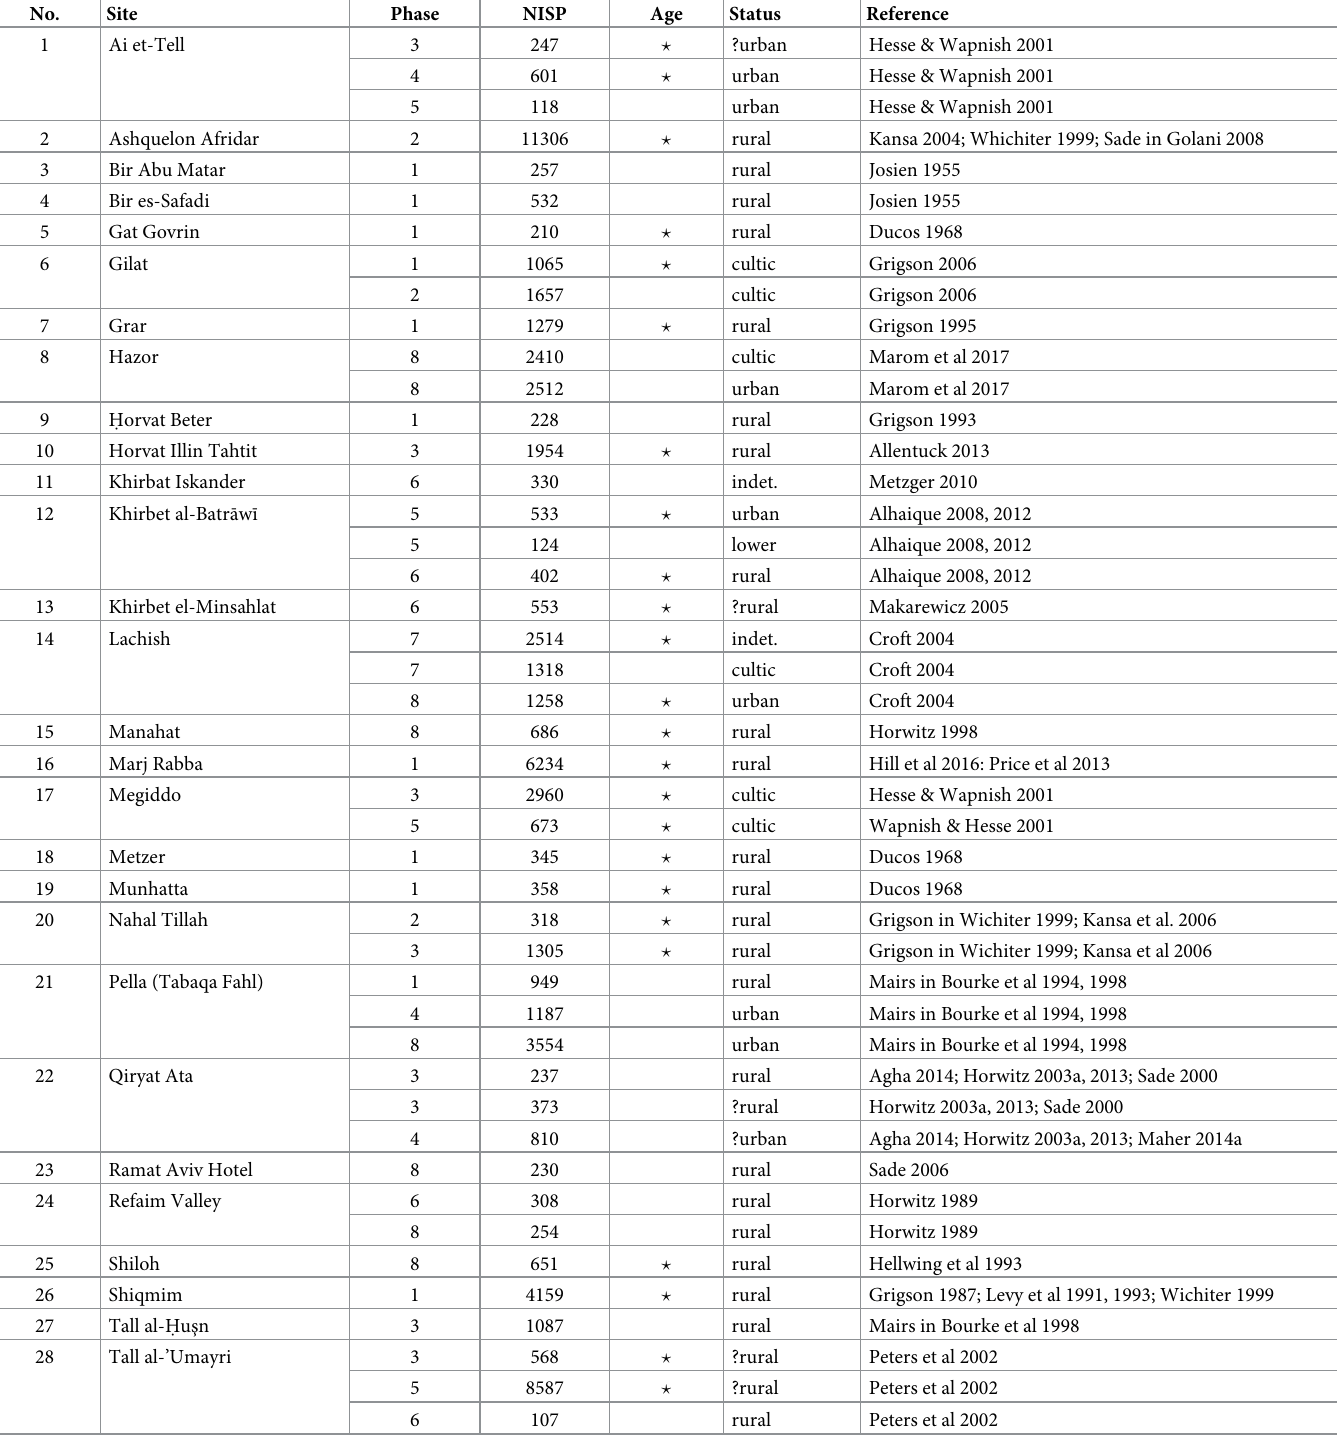
Table 2. Summary information for faunal samples compared in this study. The date ranges for chronological phase-groups and periods can be found in Table 1. Full bibliographic citations for the faunal samples used in this study can be found in SI3. Those sites which provided dental age data are marked in the ‘Age’ column with a ? .